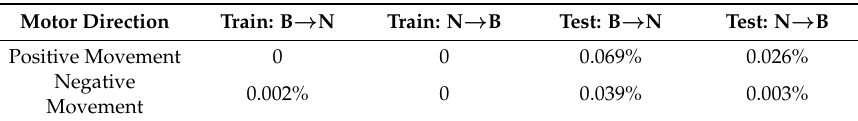
Table 2. The prediction error rate of the classification.